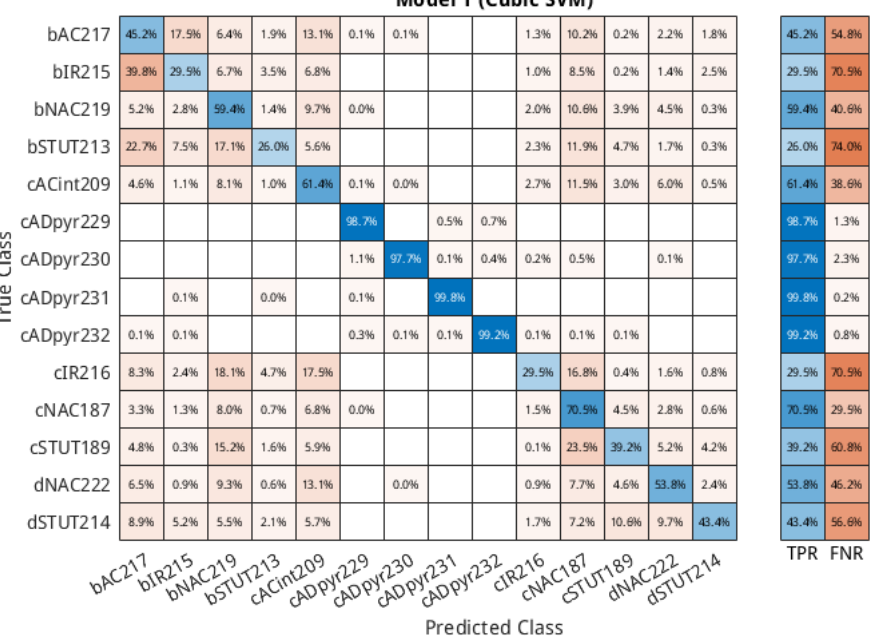
Figure A1. E-type confusion matrix. The colors represent the level of performance of the classification task per cortical layer. Blue represent strong performance level, and red represent weak performance level. The darkness of the color represents its value, being the darkest the highest